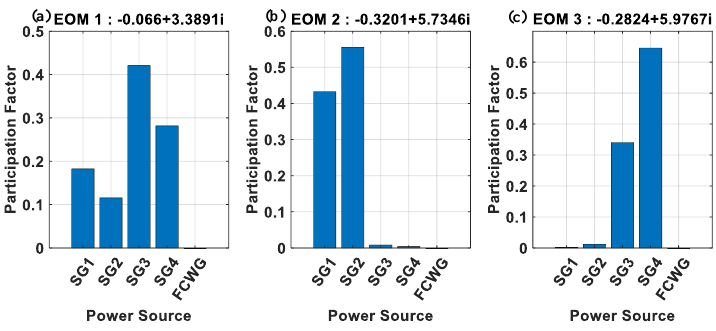
Figure 7. The participation of power sources in EOMs: ( a ) EOM1; ( b ) EOM2; ( c ) EOM3.